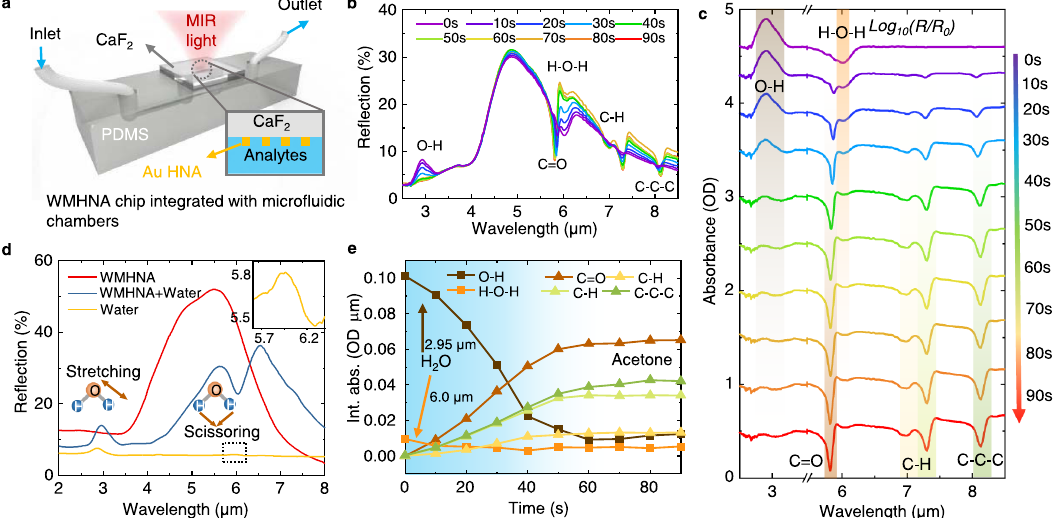
Fig. 5 Demonstration of broadband liquid dynamics monitoring of acetone and water using WMHNA integrated with micro fl uidics. a The schematic drawing of WMHNA chip integrated with PDMS micro fl uidic chamber. b The dynamic monitoring of broadband spectra of WMHNA with acetone injection to water. c The extracted absorbance spectra at different time. d The comparison of spectra of WMHNA with and without water. e The integrated absorbance at each absorption peak indicates the dynamic change of